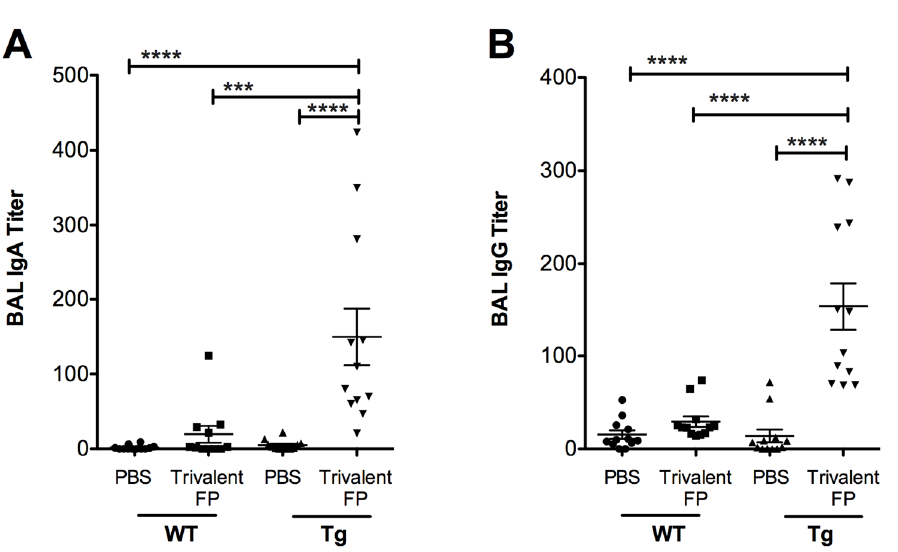
Figure 3. Trivalent-FP induced a mucosal antibody response: groups of WT (wild type) and Tg (transgenic) mice were immunized with PBS or Trivalent-FP (208 pmol) via the intranasal route, and bronchoalveolar lavage (BAL) was collected at 14 days post-booster immunization. S. pneumoniae- specific IgA ( A ) and IgG ( B ) titers in BAL were evaluated by ELISA. Mean ± SE of data from two independent experiments is shown ( n = 12 / group, *** p = 0.001, **** p = 0.0001). Statistical significance between indicated groups was evaluated by Mann–Whitney nonparametric test.